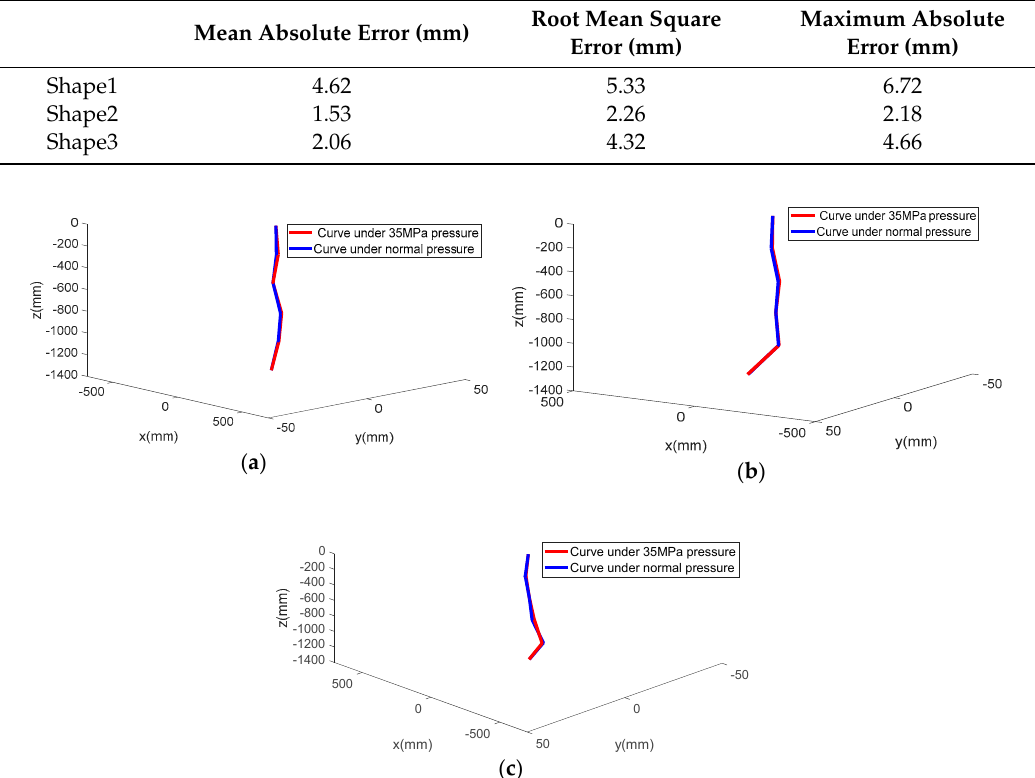
Table 1. The measurement errors.